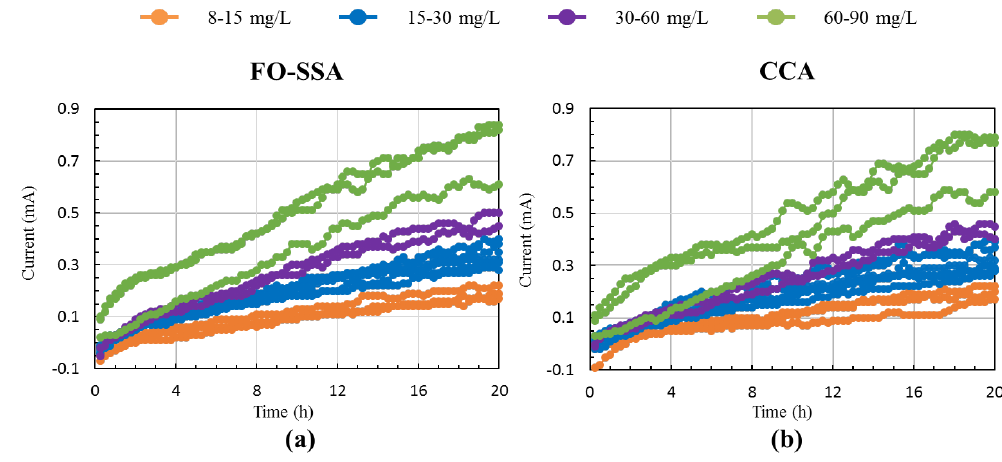
Figure 2. Current generation profiles of ( a ) FO-SSA and ( b ) CCA fed with the indicated concentrations of BOD 5 .